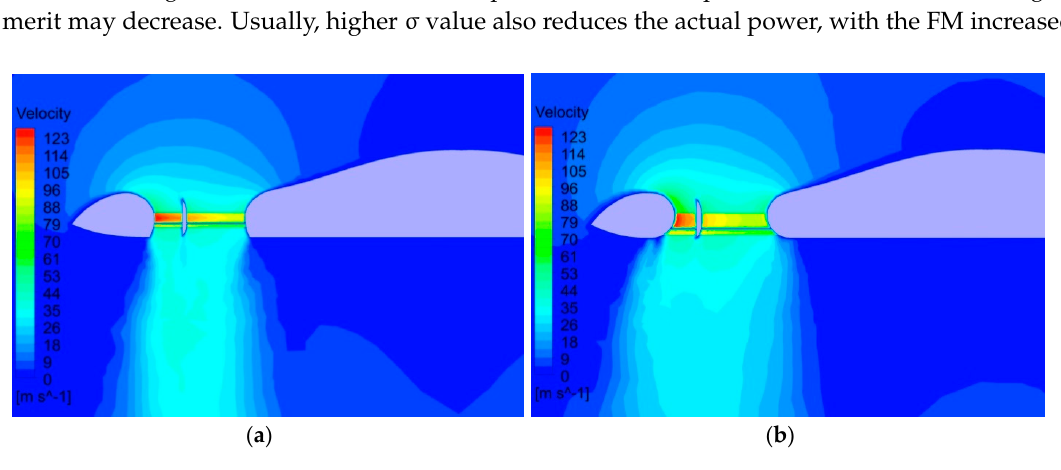
Figure 5. Velocity contour in the central plane of aircraft to show the diffusion of downstream flow. ( a ) Original fan; ( b ) New fan configuration.